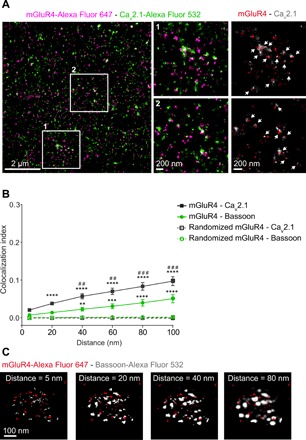
Arrangement of mGluR4 relative to bassoon and CaV2.1 channels by distance-based colocalization analysis.(A) Two-color dSTORM imaging of mGluR4 (magenta) and CaV2.1 channels (green). Left: Representative super-resolved dSTORM image revealing the organization of mGluR4 relative to CaV2.1. Middle: Enlarged views corresponding to the regions delimited by the white boxes. Right: Images of same regions, where mGluR4 localizations are shown in red over CaV2.1 localizations in gray (areas with no or low mGluR4 localization densities, corresponding to sites outside AZs, are not shown). White arrows, areas of colocalization between mGluR4 and CaV2.1. (B) Distance-based colocalization analysis. The colocalization index values calculated over increasing distance, corresponding to the SD of the Gaussian filter applied to the bassoon or CaV2.1 channel, are reported. Results were compared to those obtained with an equal number of random uniformly distributed mGluR4 localizations (dashed lines). Data are means ± SEM of 7 or 10 dSTORM images from two independent preparations each, coimmunostained for mGluR4 and bassoon or mGluR4 and CaV2.1, respectively. Differences are statistically significant by two-way ANOVA followed by Holm-Sidak’s test. (C) Principle of the analysis. A Gaussian filter with increasing SD is applied to the bassoon channel, allowing the estimation of colocalization between mGluR4 and bassoon over increasing distances (see Materials and Methods for details). **P < 0.01, ***P < 0.001, and ****P < 0.0001 versus random localizations. ##P < 0.01 and ###P < 0.001 versus mGluR4-bassoon.